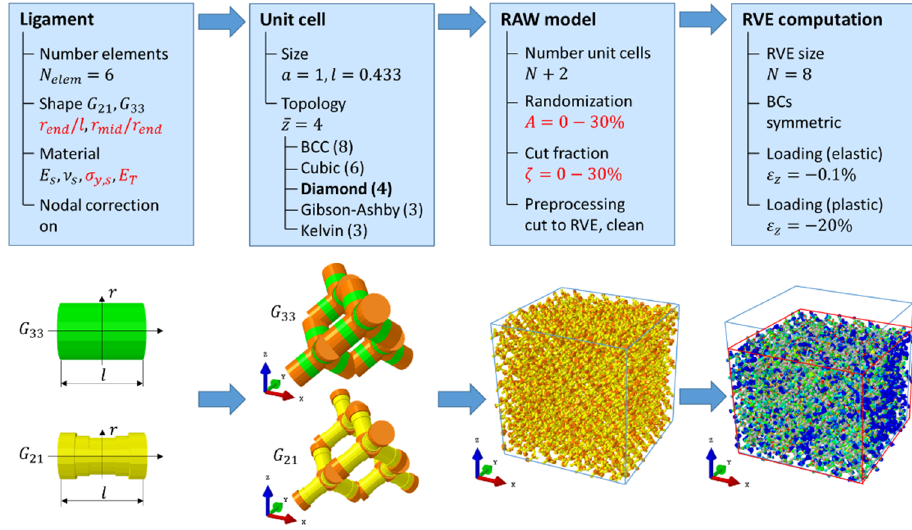
Figure 1. Workflow for generating a representative volume element (RVE) in four steps: (i) ligament, (ii) unit cell, (iii) RAW model after cutting and cleaning, and (iv) computation of the RVE. Varied parameters are highlighted in red color. Table 1. Ligament shapes used for the generation of two data sets in the low and a high solid fraction regime,